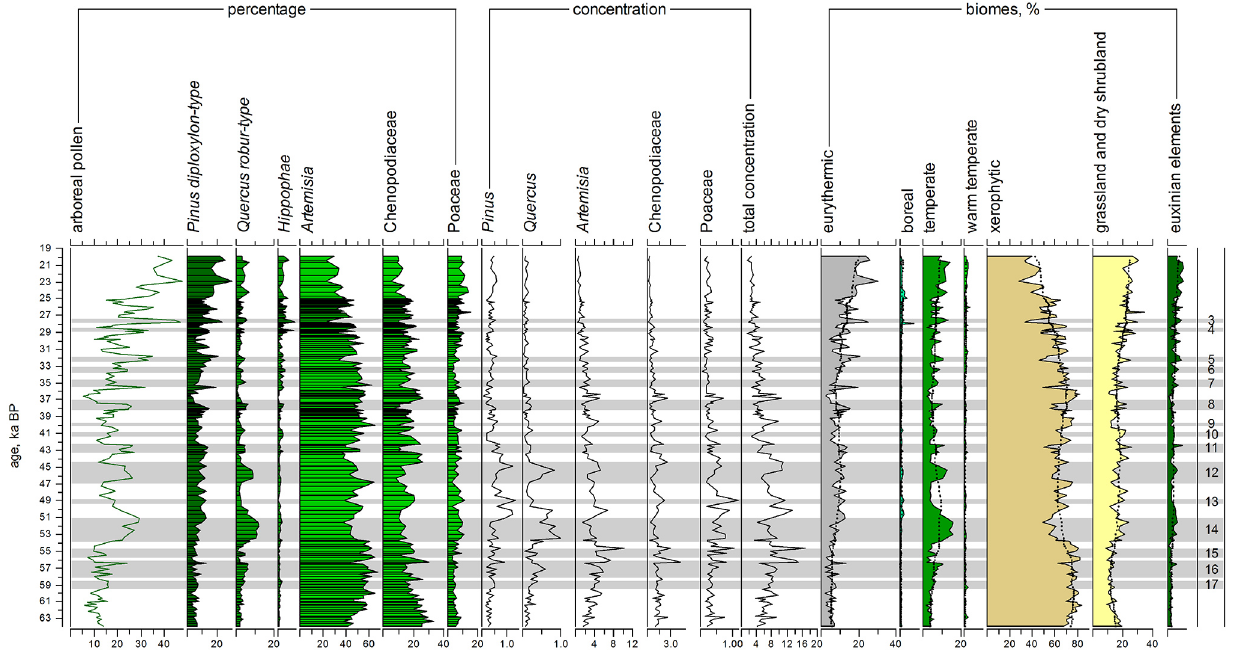
Fig. 3. Percentage (%) and concentration (grains × 10 3 cm − 3 ) diagram of main pollen taxa and percentages of biomes, grouped following Fletcher et al. (2010) (Table 1), versus age. Percentages were calculated on a total pollen sum. Eurythermic, temperate, xerophytic as well as grassland and dry shrubland biomes percentages are plotted with a smoothed curve (dotted curve, simple moving 20 points average). Horizontal grey bars with numbers indicate GI as identified by the 25-GC1 CaCO 3 (GI 17-5) and dinocyst (GI 4 and 3) records.